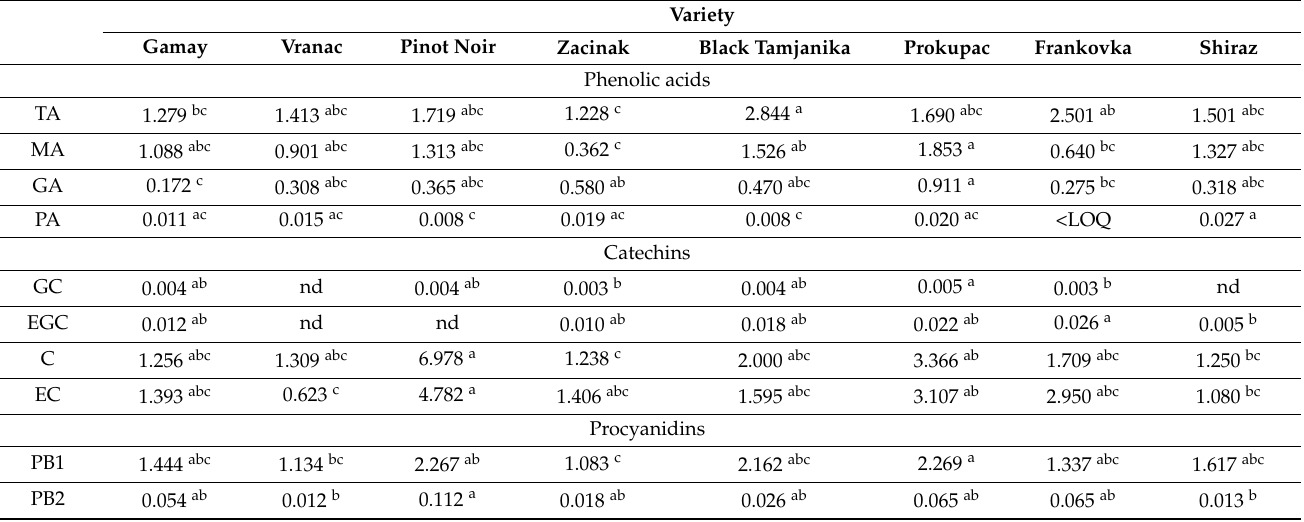
Table 2. Phenolic compounds quantified in EtOH GSEs (results are expressed as mg/g of dry weight). Variety